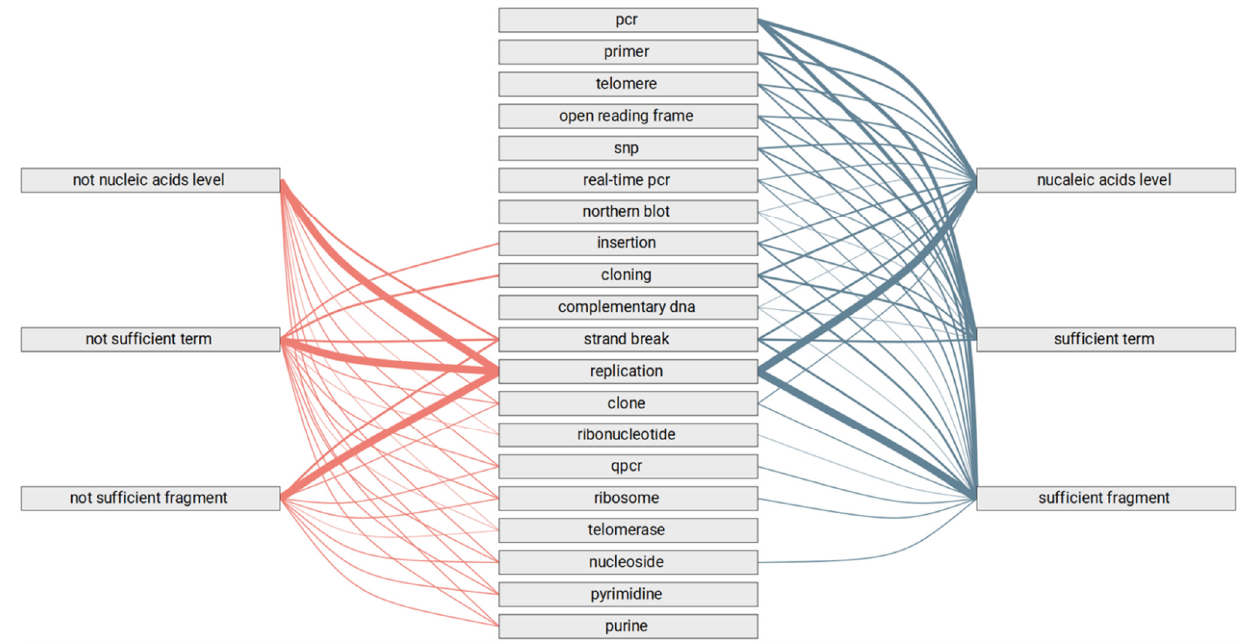
Figure 5. Association between the terms from the DNA/RNA category of the dictionary and answers obtained during the manual review. Thicker lines connecting the term and an answer mean more cases. Blue lines connect terms and positive answers. Red lines connect the terms and negative answers.